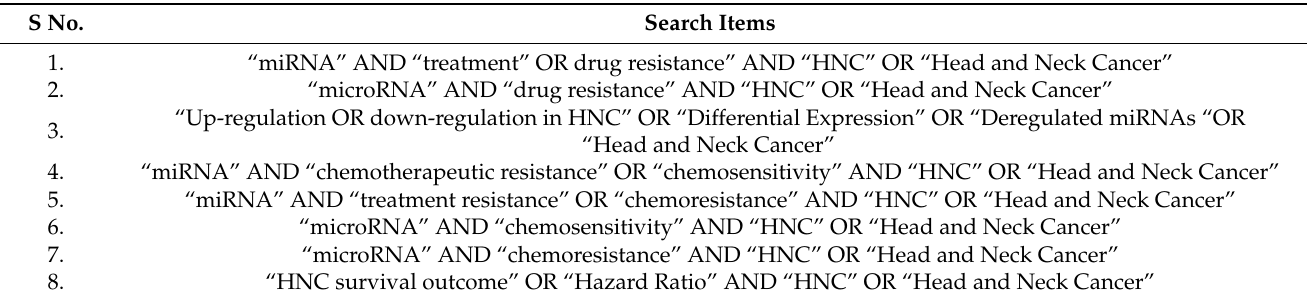
Table 1. A sample keyword search